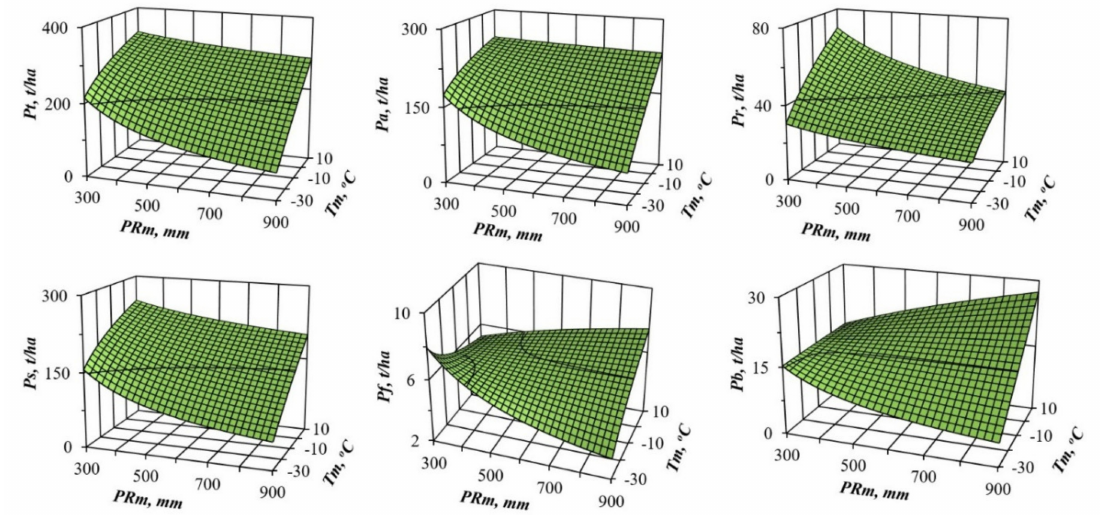
Figure 2. The relation of pine biomass to the averaged temperature of January ( Tm ) and averaged precipitation ( PRm ) at the stand age of 100 years. Designations: Pt , Pa , Pr , Ps , Pf and Pb are the biomass of total (above- and underground) wood storey, aboveground storey, underground storey (roots), stems (wood and bark), foliage and branches correspondingly, t per ha.